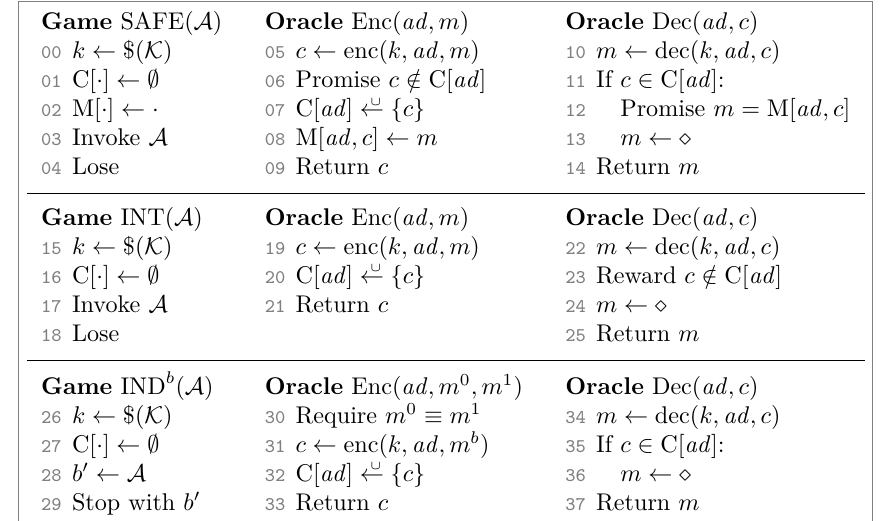
Figure 1: Games for AEAD. For the values ad , m, m 0 , m 1 , c provided by the adversary